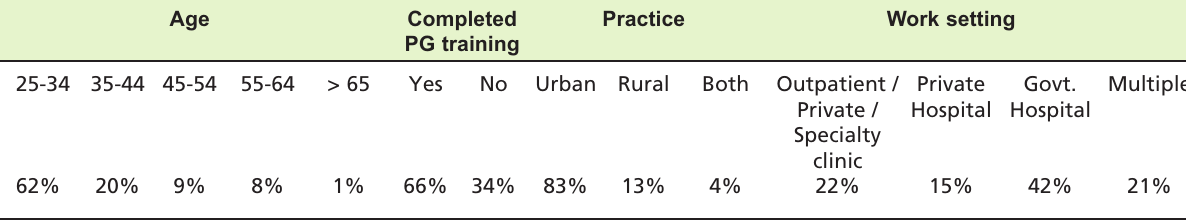
Table showing respondents demographics and work setting details Table II: